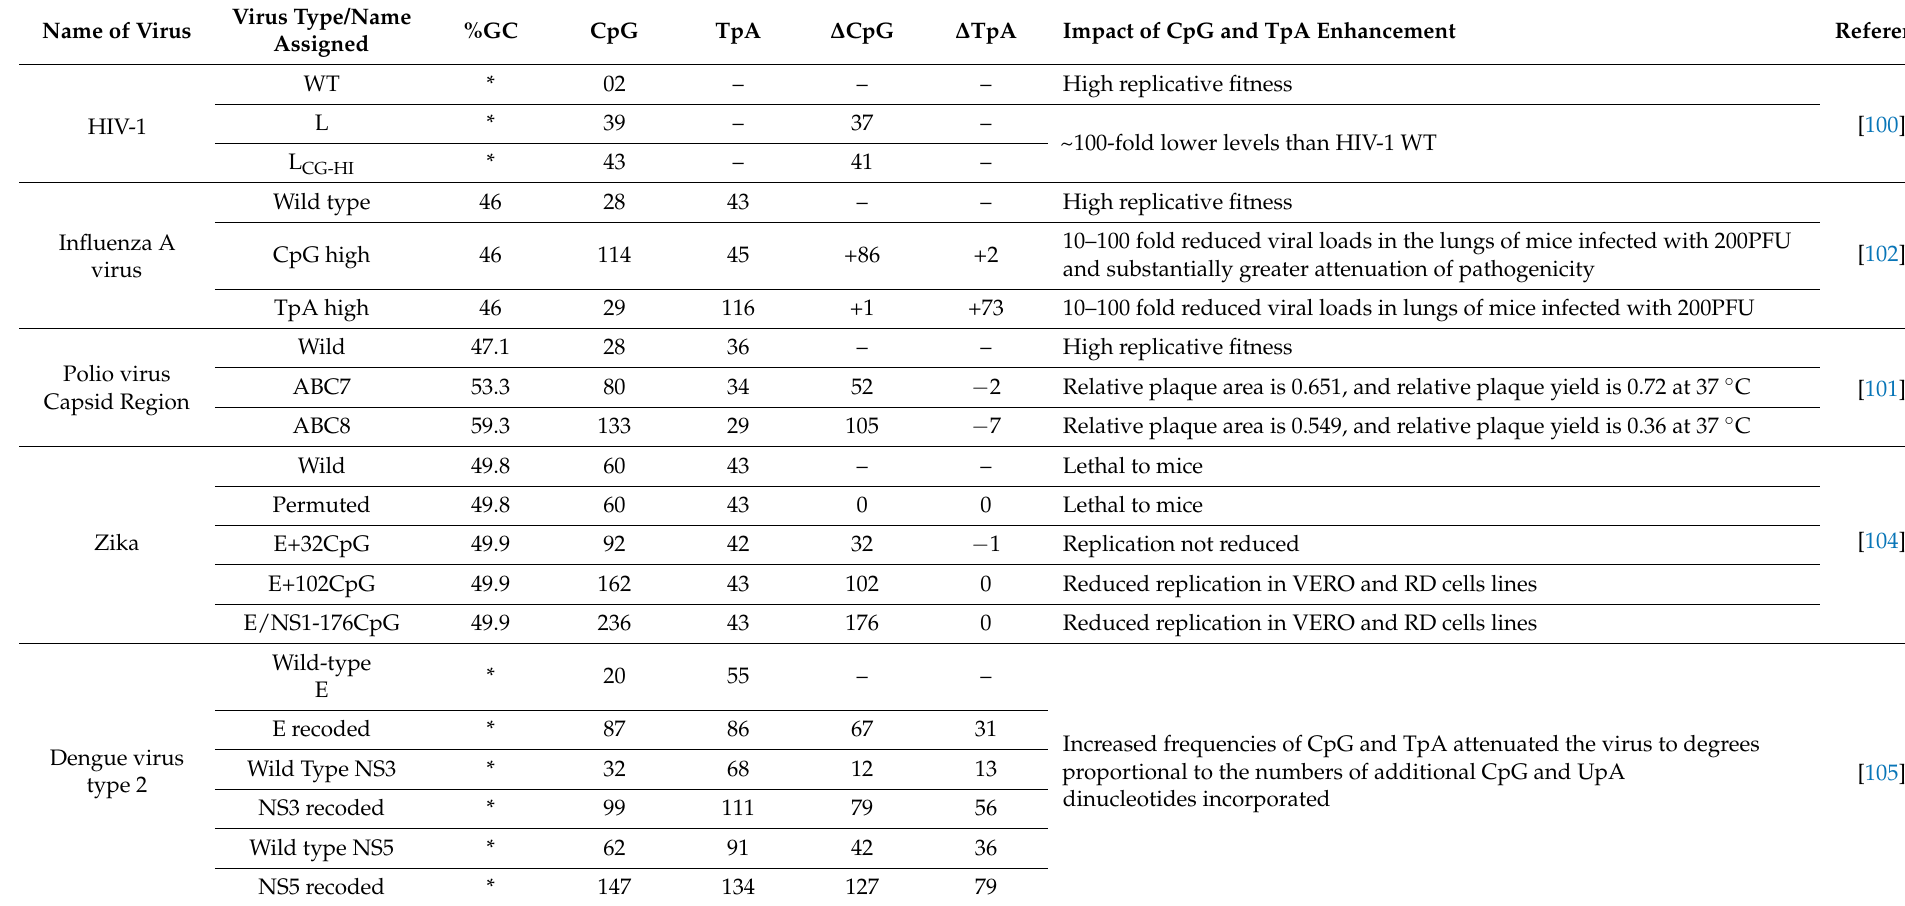
Table 8. Impact of CpG and TpA enhancements and genomic compositions on different